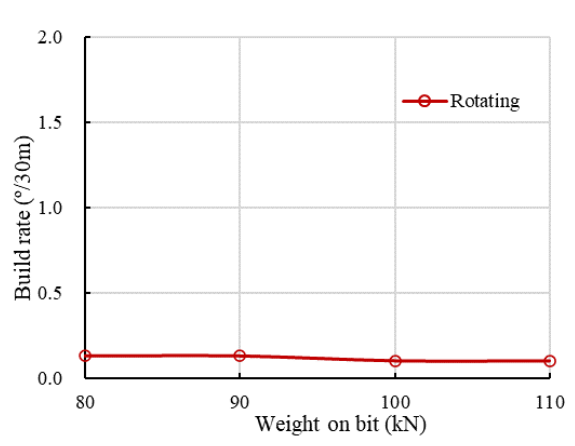
Fig. 17. Rotating build rate VS WOB for BH-PDM-D